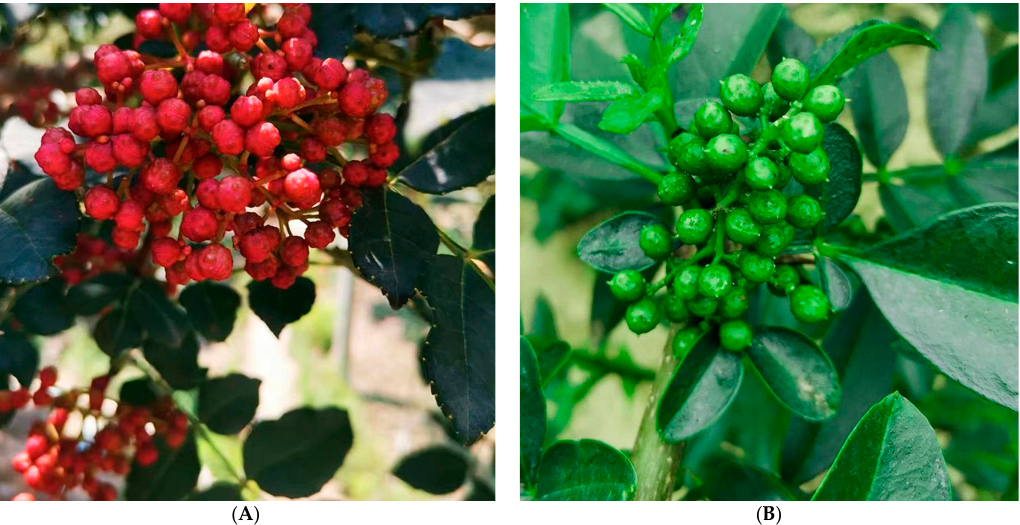
Figure 1. Photograph of Zanthoxylum . ( A ) The fruits of Z. bungeanum ; ( B ) the fruits of Z. armatum.